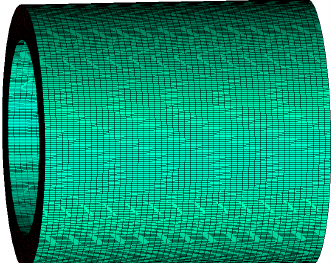
Figure 1. Three-dimension model of the multiphase pump.